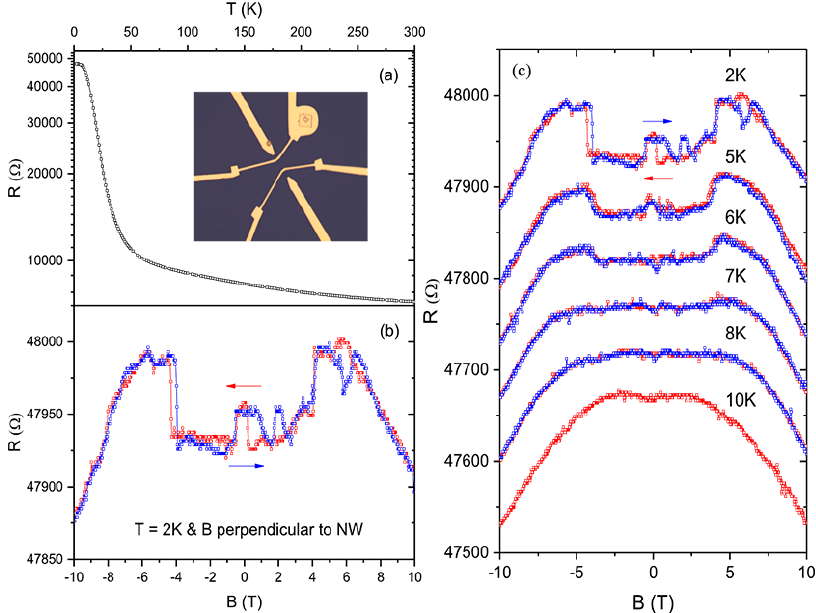
Figure 14. ( a ) The temperature dependence of resistance of a single SmB 6 nanowire with a D value of 45 nm. The inset shows the fabricated four-probe device. ( b ) Double-sweep magnetoresistance curve with B perpendicular to the NW and T = 2 K. The field sweeping directions are indicated by arrows. ( c ) Double-sweep MR curves of a SmB 6 NW in perpendicular magnetic fields at different temperatures. The NW diameter is 45 nm, and the field-sweeping directions are indicated by arrows. Curves are offset vertically for comparison. At T = 10 K, the MR curve was only measured in the sweep-down direction [22]. Copyright 2018,